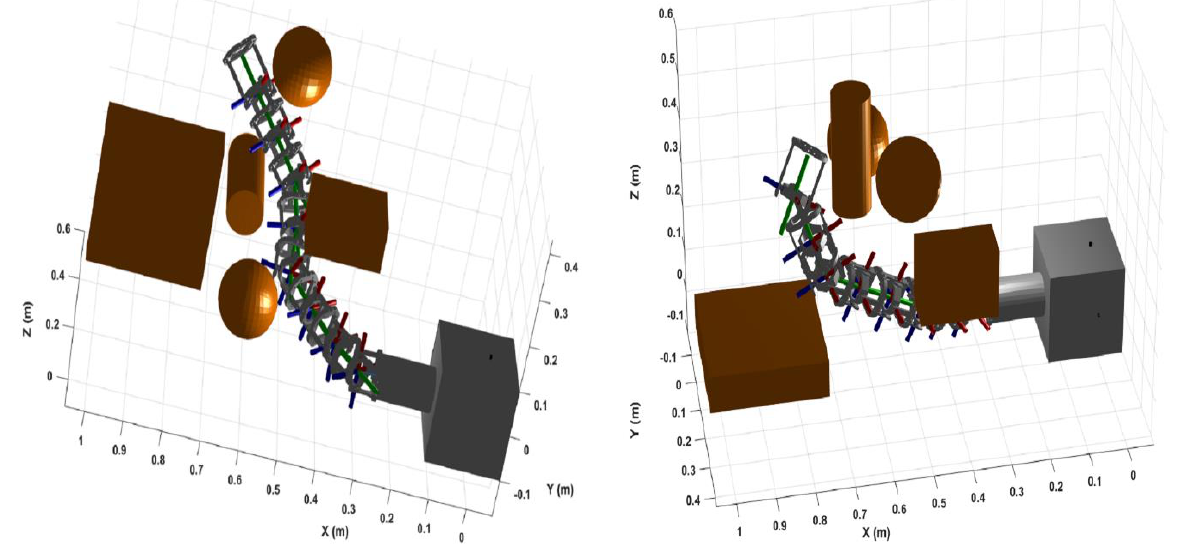
Figure 14. The manipulator configuration at the middle waypoint ( left ) and the final pose ( right ).